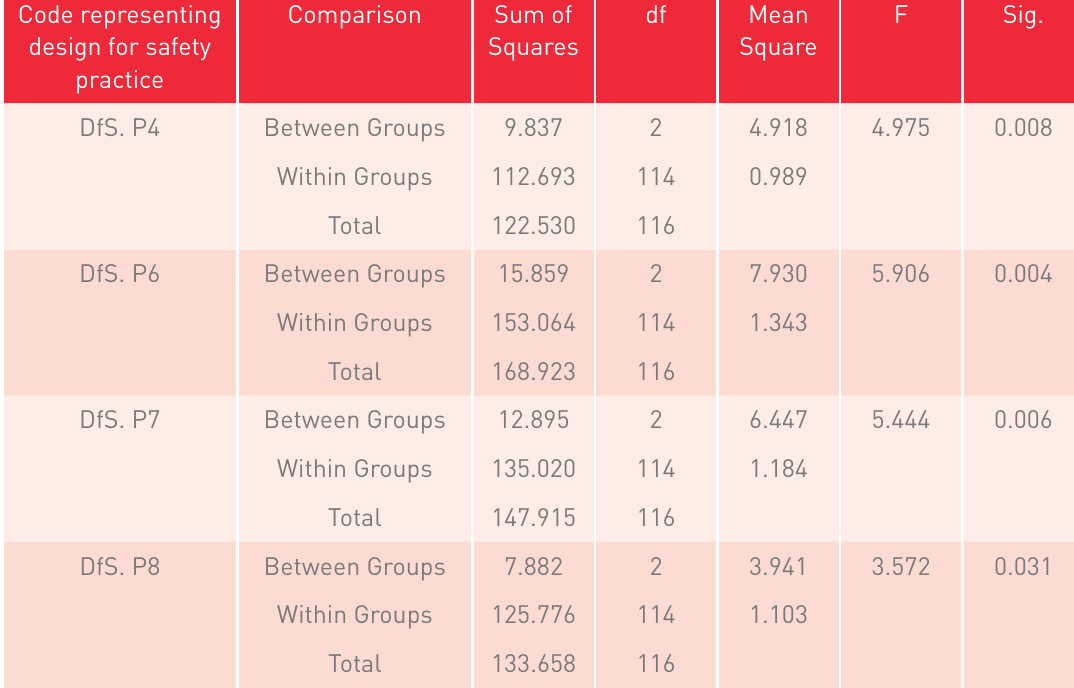
Table 12. ANOVA results based on designers' years of experience in role. Code